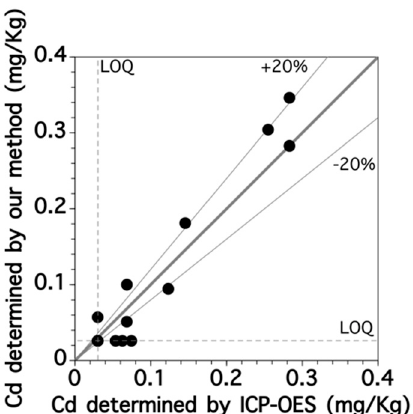
Figure 8. Relationship between concentrations of Cd in brown rice samples determined by fluorescence spectroscopy with the fluoroionophore and by ICP-OES.